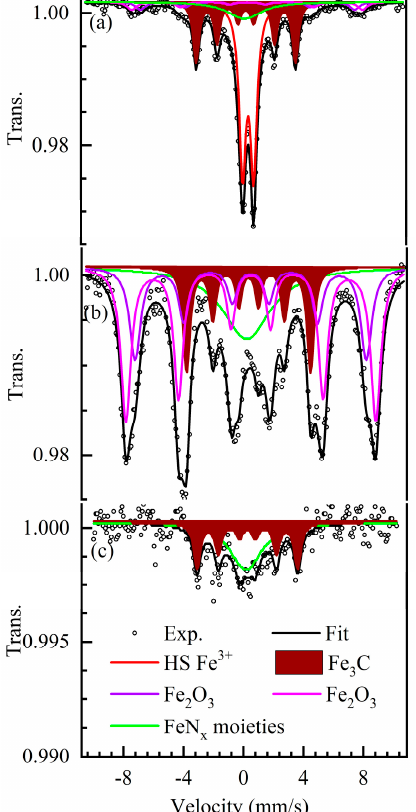
Figure 3. 57 Fe Mössbauer transmission spectra and their fittings with spectral components. ICM- measured at ( a ) 293 K and ( b ) 5 K, and ( c ) ICM-FePhen 3 -AW measured at 293 K. Table 1. Mössbauer parameters derived from the fittings: relative area (RA, %), isomer shift (IS, mm/s), quadrupole splitting (QS, mm/s), line width (LW, mm/s) and magnetic field (H, Tesla) of each component. Subscript number after the RA% number indicates the error bar, in %. Sample